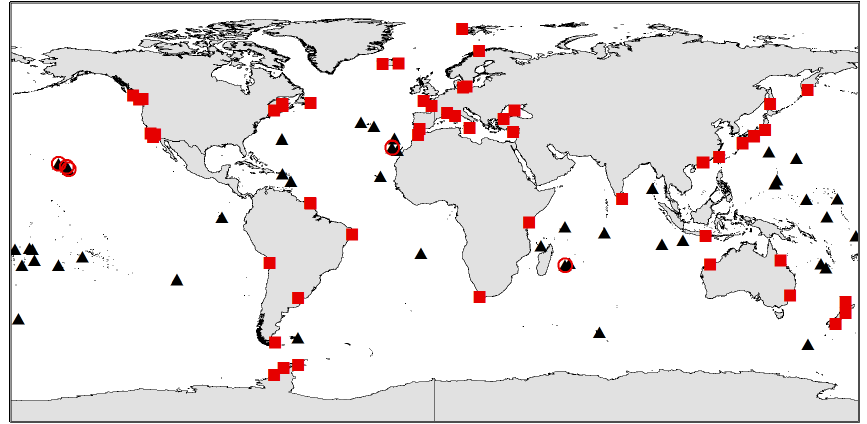
Figure 3. The distribution of GNSS sites within 100km compared to HY-2A subsatellite points, including 46 on islands (black triangle) and 56 on the mainland coastline (red square). Five of them (red circle) are higher than